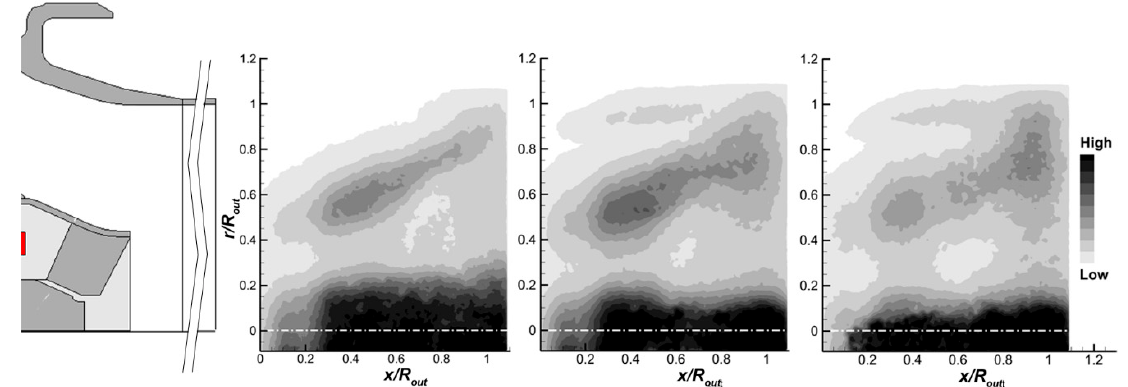
Figure 6. PLIF (Planar Laser Induced Fluorescence) measurements: Average OH concentration maps for (from left side to right side) operating conditions from #1 to # 3 ( λ = 3.60, 3.25, and 2.90, respectively).